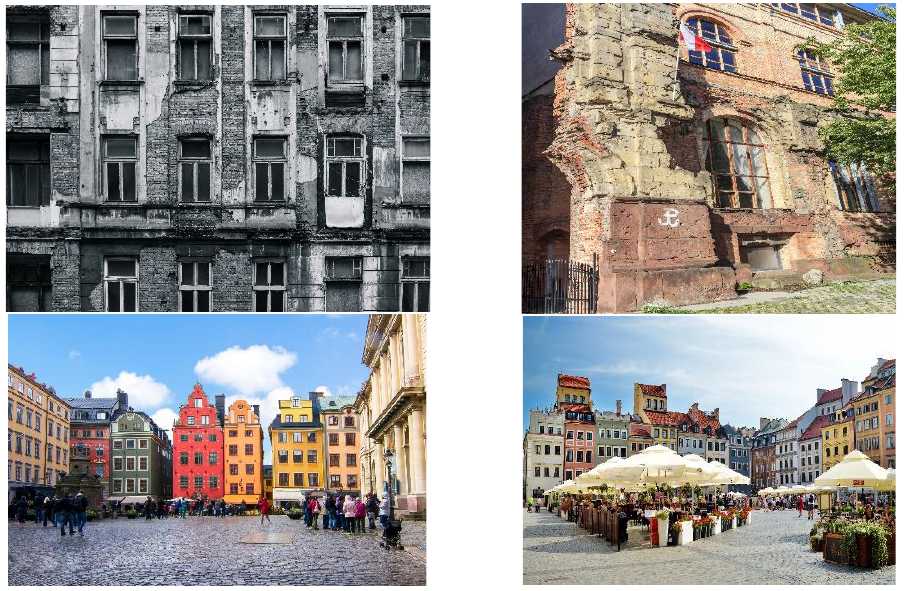
Figure 1. Some heritage buildings in Warsaw during the war and after the reconstruction process of the city (credit: https://www.shutterstock.com/ (accessed on 15 August 2022))